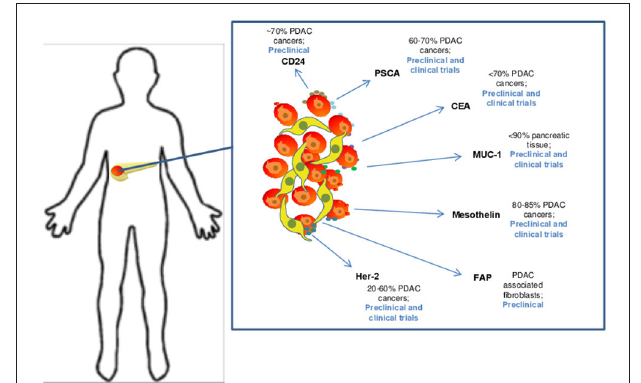
FIGURE 2 | Candidate target antigens for CAR T cell therapy in pancreatic ductal adenocarcinoma. Several target antigens for CAR T cell therapy have been identified and are being studied in both preclinical and clinical trails. These antigens are expressed at varying levels on PDAC cells and include CD24 (35), Prostate stem cell antigen (PSCA) (36), CEA (37), MUC-1 (38), Mesothelin (39), FAP (40), and Her-2 (41).